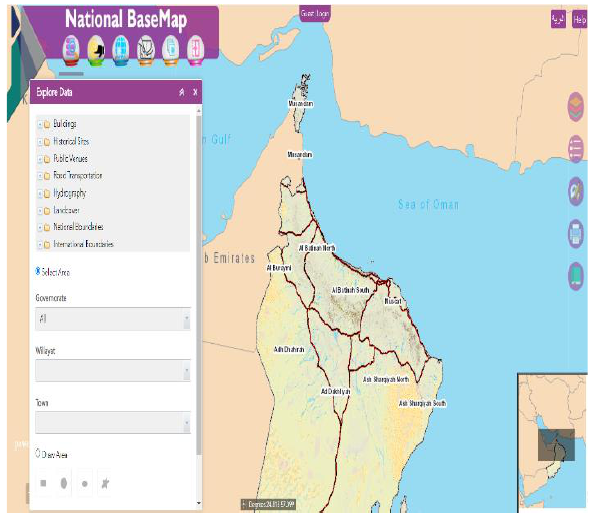
Figure 1 . The Unified National Basemap (UNB).